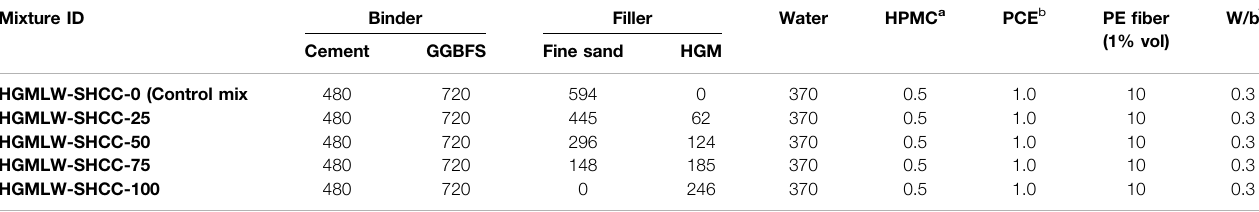
TABLE 1 | Mix design of HGMLW-SHCC (kg/m 3 ).